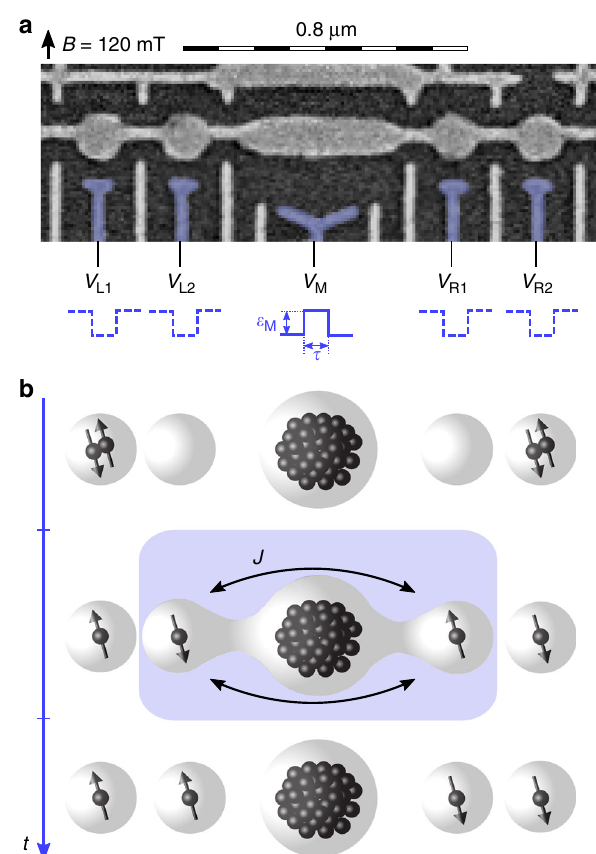
Fig. 1 Detection of spin-exchange processes across a multielectron dot. a Scanning electron micrograph of the measured device. A multielectron dot is induced below the long segment of the horizontal gate electrode, while two two-electron double quantum dots are induced below its circular sections. Nanosecond voltage pulses applied to the blue-colored gates V j control the position of individual electrons and their mutual interactions. An external magnetic fi eld (arrow) is applied in-plane of the device. b Operation steps. First, each double dot is initialized in a singlet state | S L/R 〉 , by populating the outer dots with two electrons each. Then, single electrons are moved to the inner dots, thereby turning off their exchange interaction with the outer electrons, which serve as reference spins. Next, the exchange coupling J between the inner electrons is induced, by temporarily raising V M by an amplitude parameterized by ε M (and lowering other gates to maintain constant overall charge). The